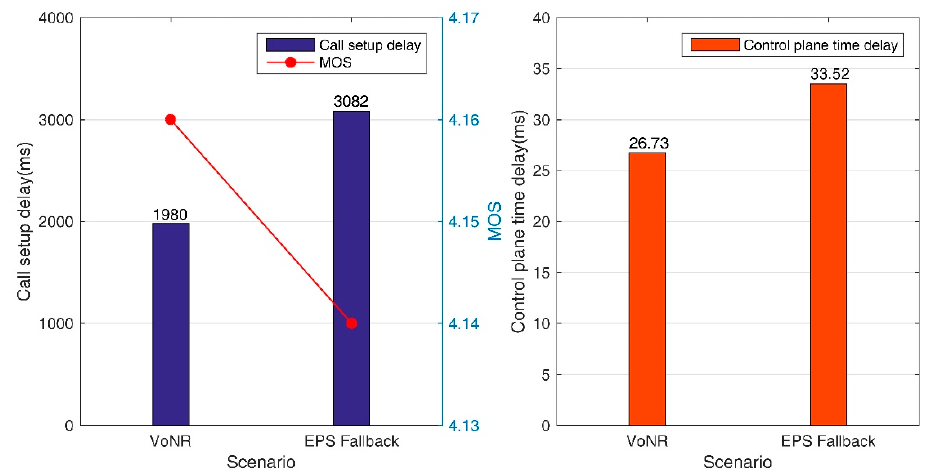
Figure 17. VoNR and EPS Fallback test results.